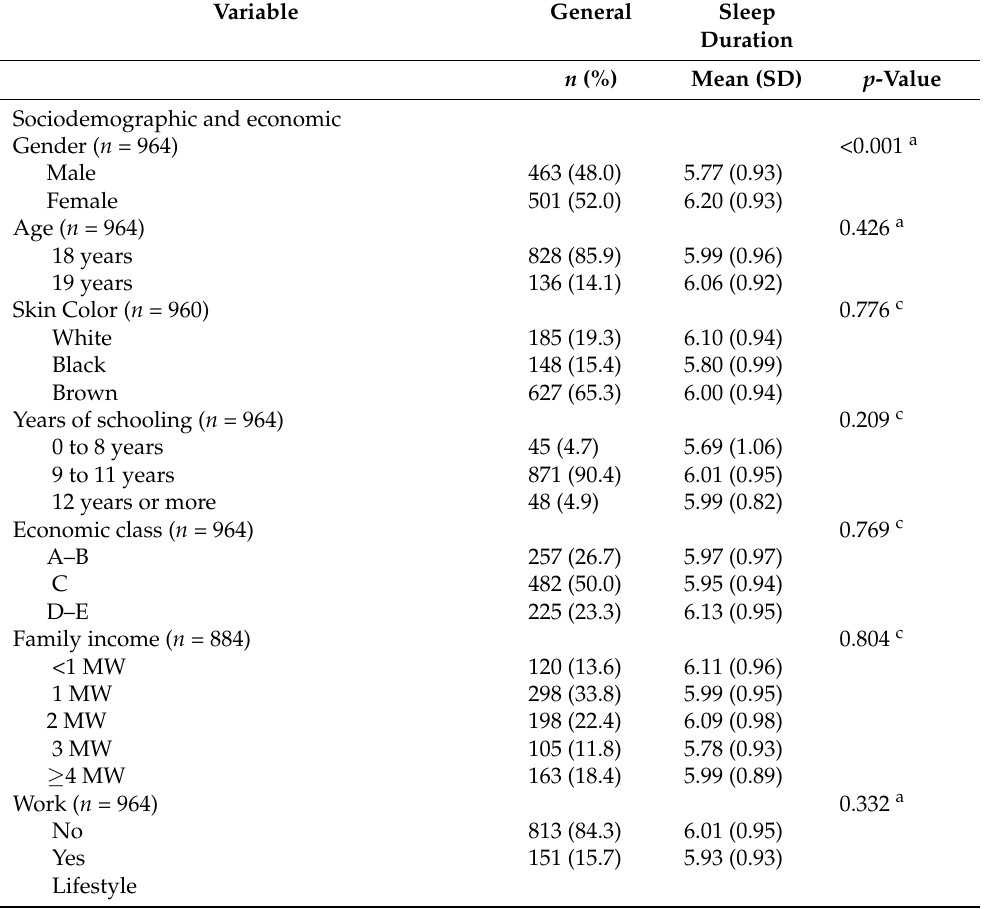
Table 2. Characterization of the general sample and the mean sleep duration according to sociodemo- graphic, economic, anthropometric, and behavioral characteristics in adolescents. S ã o Lu í s, Maranh ã o, Brazil,